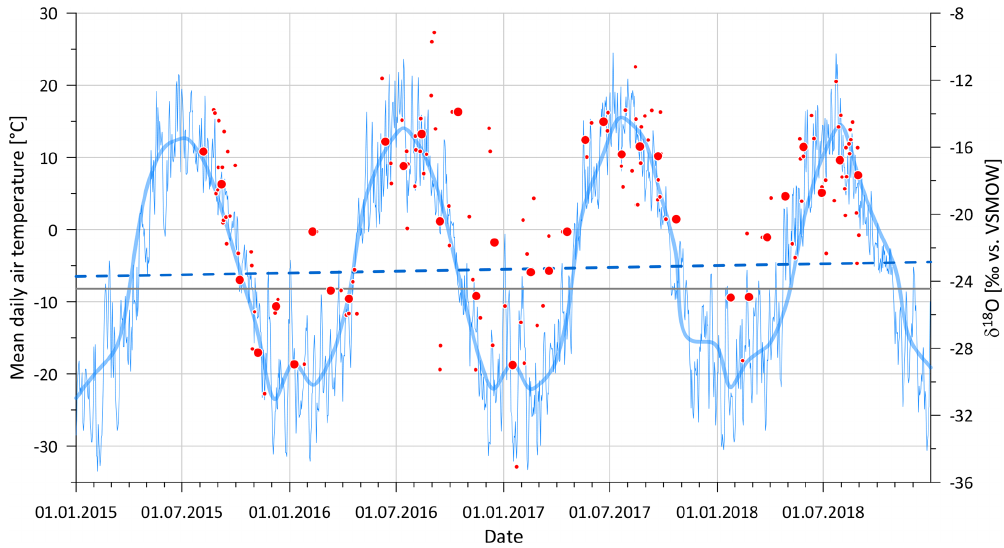
Figure 2. Air temperatures from Inuvik (NT, Canada) together with δ 18 O values in precipitation during the sampling period from August 2015 to August 2018. Thin blue line shows mean daily air temperatures and the thick blue line shows monthly averages. Small red dots show all δ 18 O data points. Large red dots show δ 18 O monthly averages. Grey line illustrates long-term average of air temperatures (1981–2010). Blue dashed line illustrates air temperature trend from 2015 to